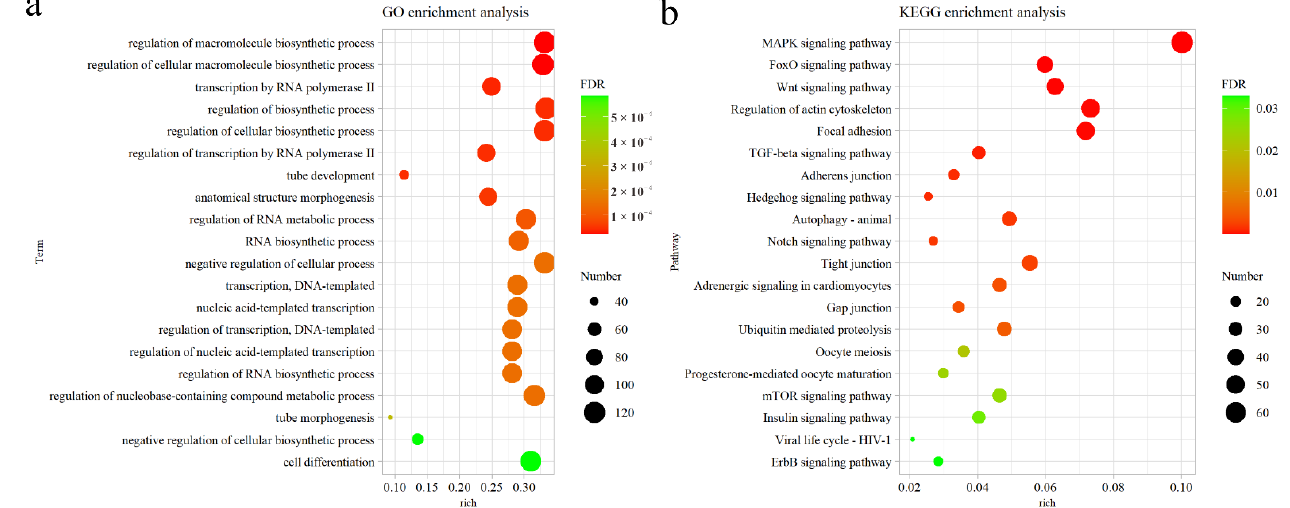
Figure 4. Functional enrichment analysis of genes targeted by 12 candidate miRNAs. ( a ) The top 20 enriched GO terms in BP ( p < 0.05). ( b ) The top 20 enriched KEGG pathways ( p < 0.05).